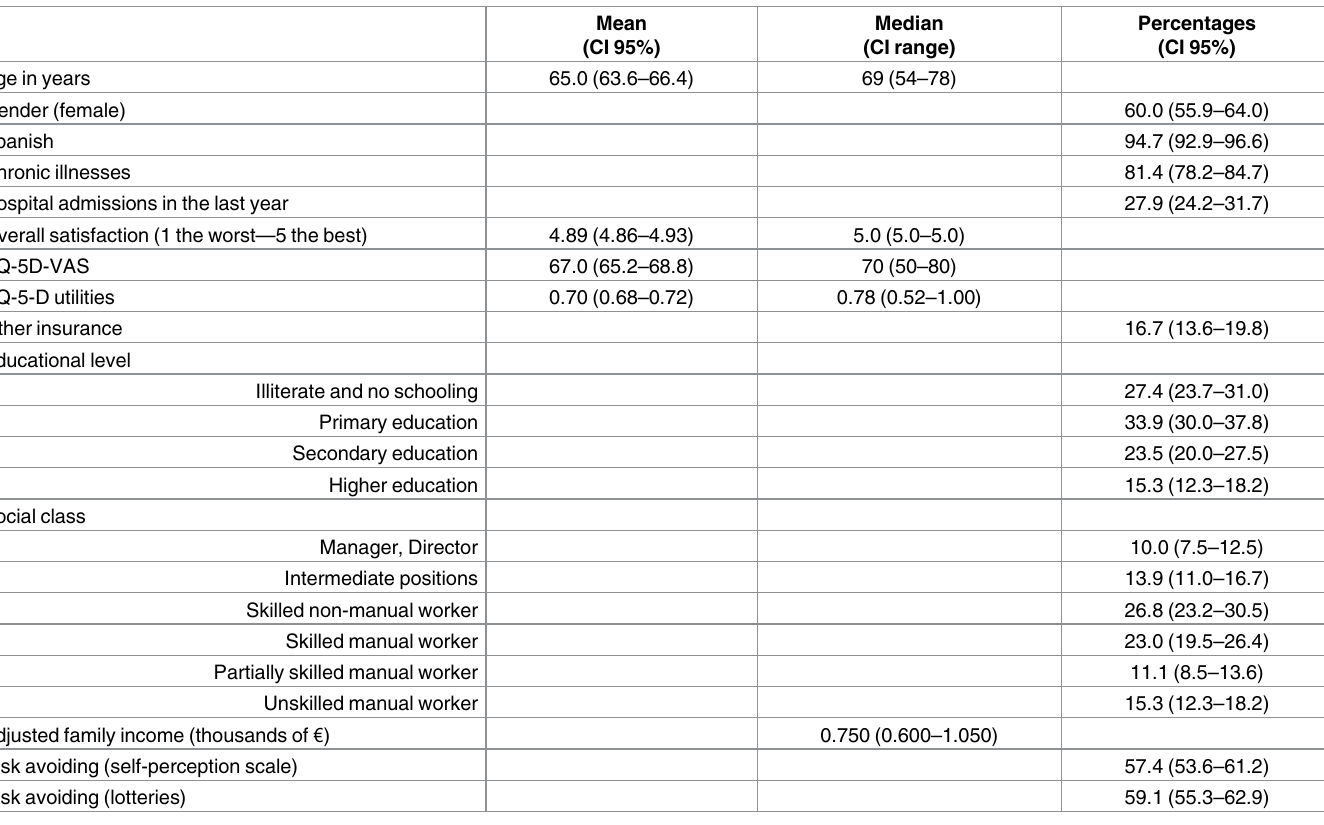
Table 1. Characteristics of the people who expressedWTA and